Question: What kind of plot is shown here?
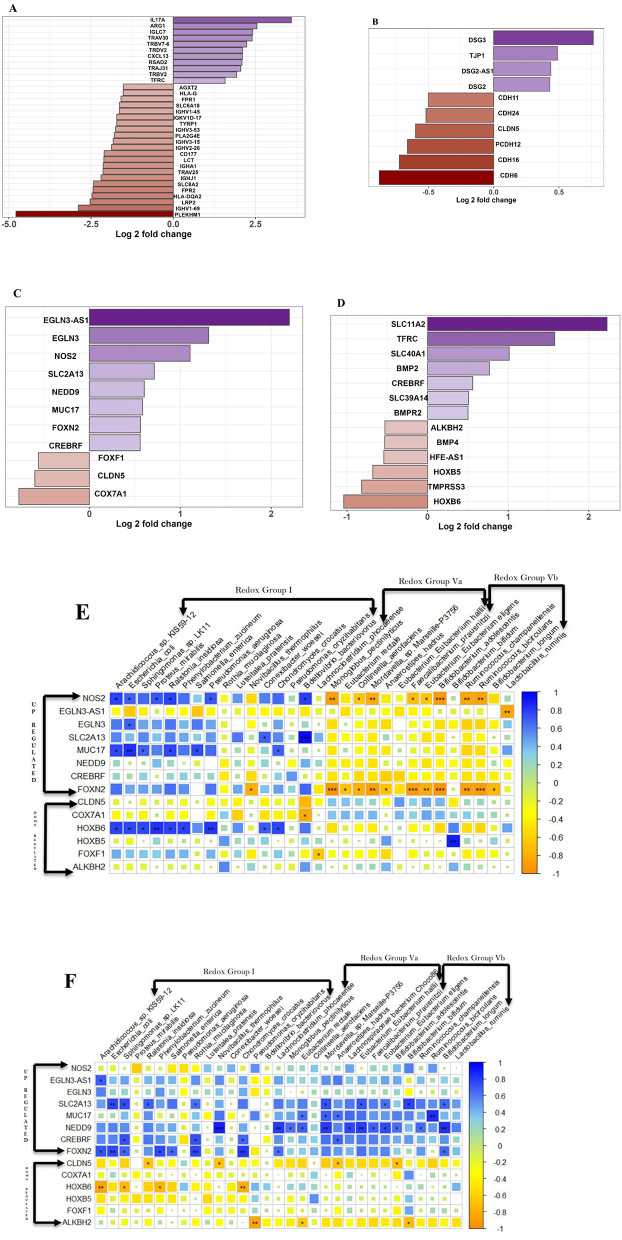
Answer: heatmap